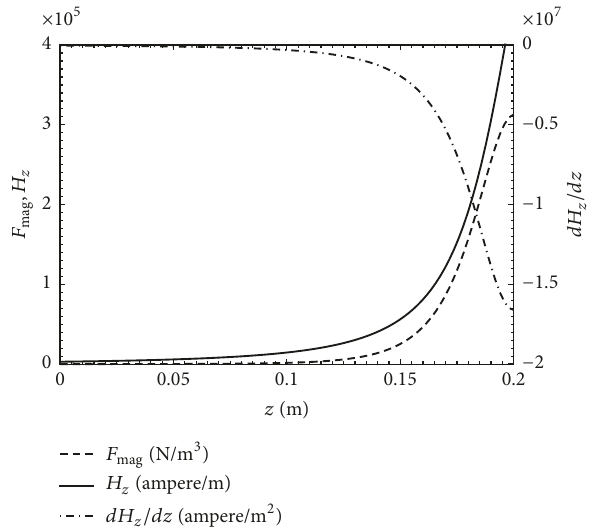
Figure 1: 𝐹 , 𝐻 𝑧 , and 𝜕𝐻 𝑧 /𝜕𝑧 are plotted against 𝑧 mag